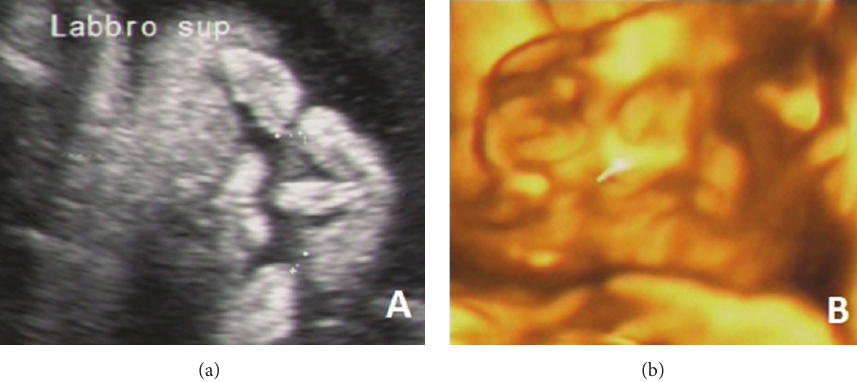
Figure 2: Bilateral cleft lip at 2D (a) and 3D (b) prenatal ultrasonographic scan at 19 and 28 weeks of pregnancy,